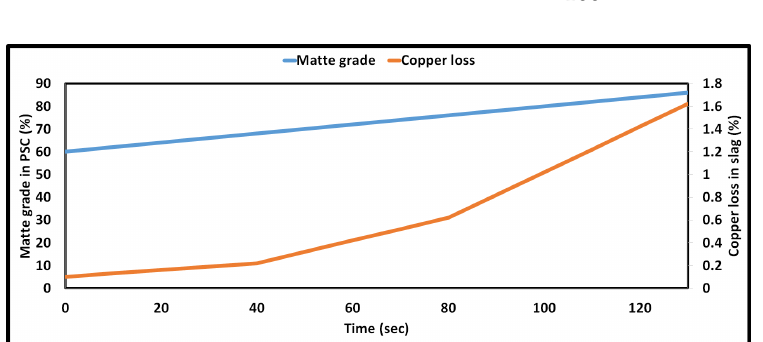
Figure 5. Estimated matte grade and copper